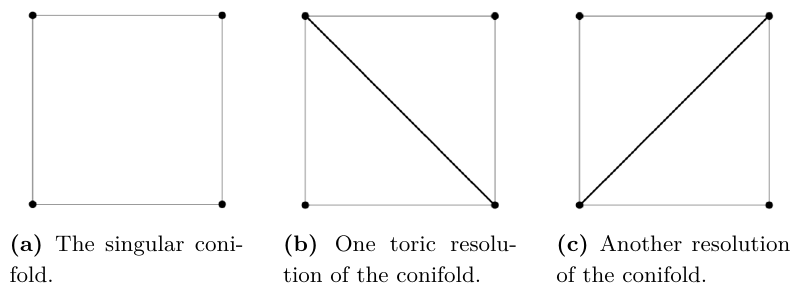
Figure 2. Toric diagrams of the conifolds and its two different resolution. Figure b related to figure c by a flop.